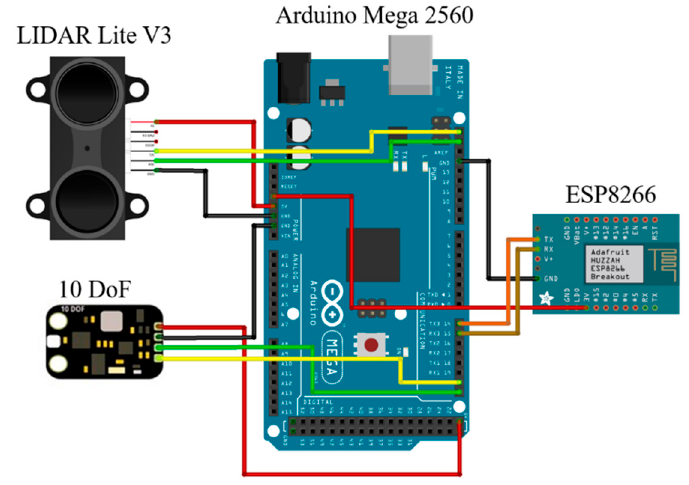
Figure 8. Electrical interface of the data acquisition and Wi-Fi communication system.